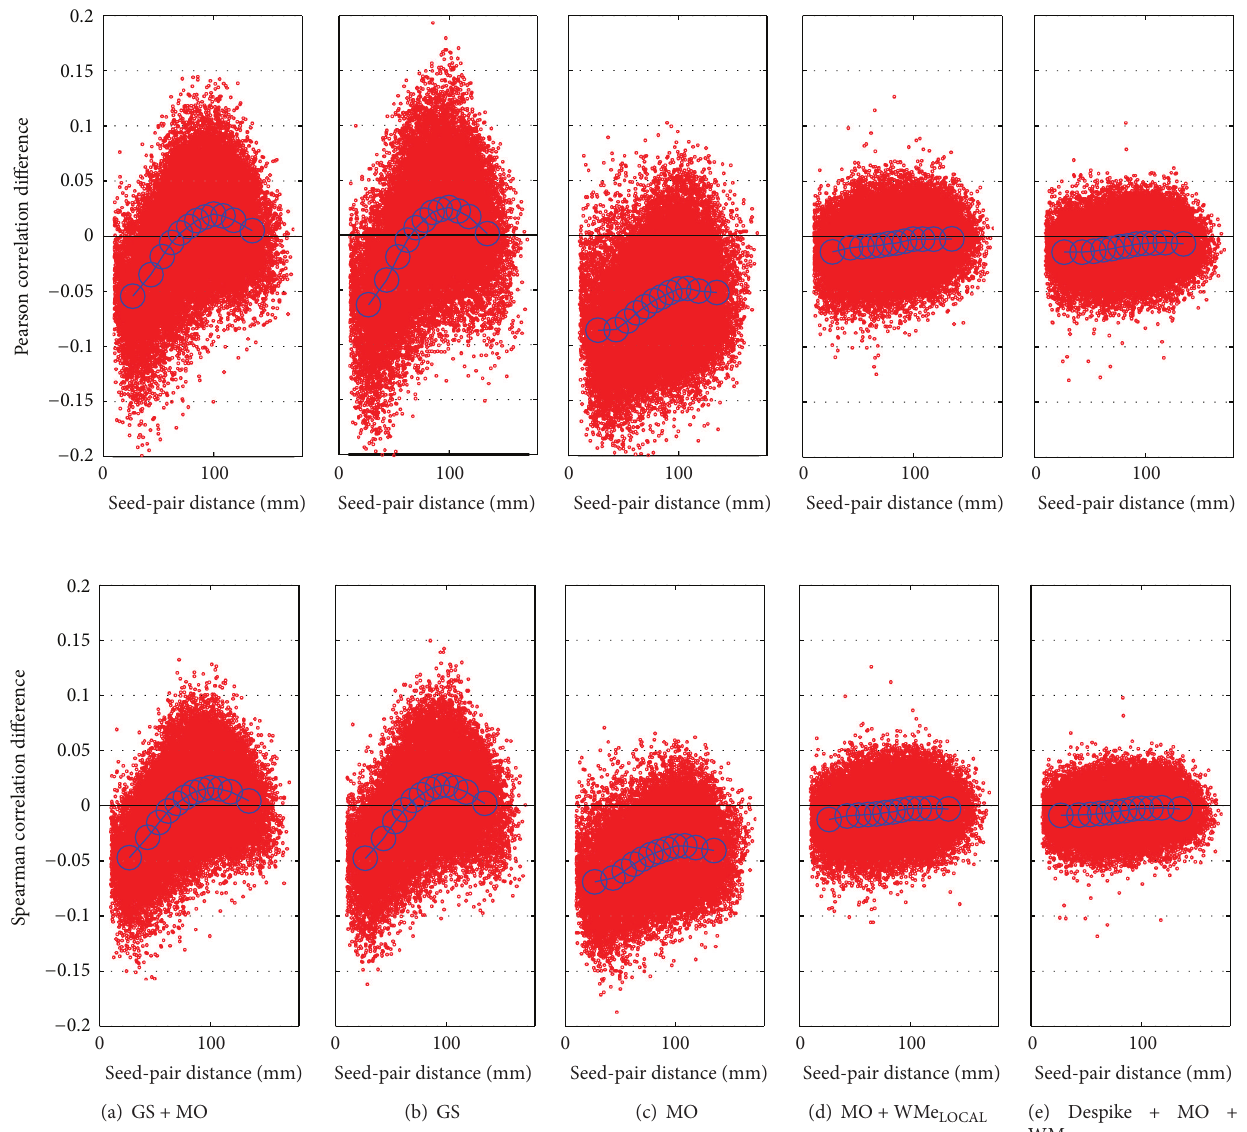
Figure 4: The column (a) shows that censoring high-motion frames from RS-FMRI data decreases short-distance correlations and augments long-distance correlations. The Pearson and Spearman correlation differences are plotted as a function of the Euclidean 3D distance between brain locations in the upper and lower rows, respectively. The results for each seed pair averaged over 22 subjects are plotted as red dots. Blue circles are the grand mean of averaged correlation differences for equal numbers of brain location pairs in twelve segments (2,882 pairs per circle), to highlight the trend. In the preprocessing steps, 6 motion estimates with their first difference terms (MO) and tissue-based regressors with their first difference terms (GS; global, eroded white matter, and lateral ventricle signals) were regressed out. Columns (b) and (c) present the distance-dependent correlation biases of nuisance regression models GS and MO, respectively. Column (d) shows results when a localized and eroded WM signal is added in the regression model of (c). Column (e) shows the model of Column (d) with the addition of despiking. The censored time points of FMRI images were determined at ‖ d ‖ 2 > 0.25 mm in (a), and the same time points were used in the censoring process of all